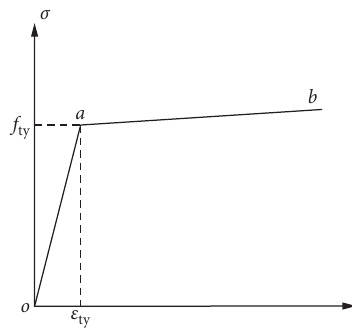
Figure 2: Steel tube stress-strain